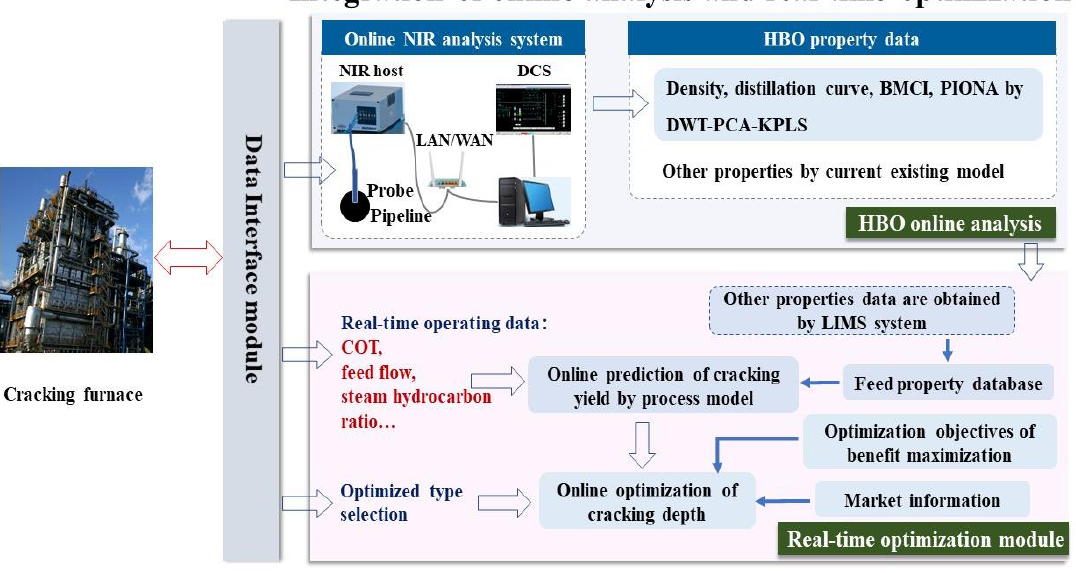
Figure 3. Real-time optimization framework of ethylene cracking process integrated with online analysis property of HBO.